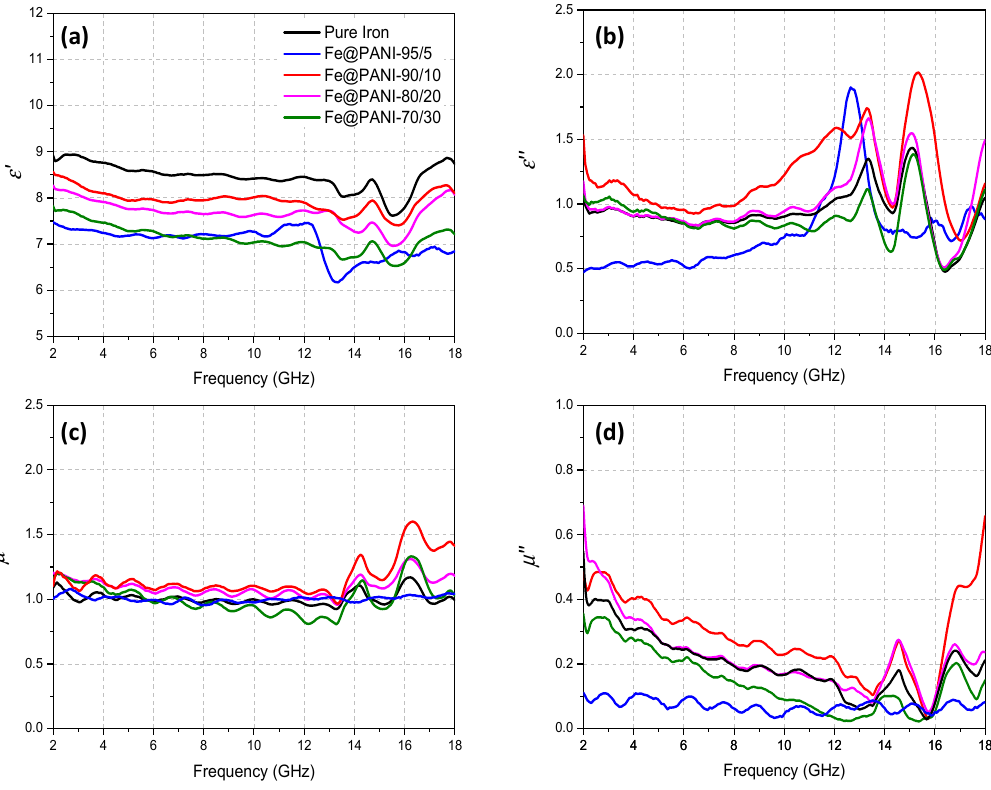
Figure 10. The measured dielectric ( a ) real part ε ′ , ( b ) imaginary part ε ″ , the magnetic ( c ) real part μ ′ , and ( d ) imaginary part μ ″ of Fe@PANI nanowires composites in epoxy resin. Higher electric and magnetic loss may result in better microwave absorption per- formance. In order to compare the dielectric and magnetic dissipation of the Fe@PANI nanowires, Figure 11 shows the dielectric loss factor (tan δ ε = ε (cid:48)(cid:48) / ε (cid:48) ) and the magnetic loss factor (tan δ µ = µ (cid:48)(cid:48) / µ (cid:48) ). Generally, dielectric loss capability exhibited two major peaks at ~13 and 15 GHz, Figure 11a. Whereas the magnetic loss capability, shown in Figure 11b, shows a downward trend within ~2–14 GHz, exhibiting a peak at ~15 GHz, and another one at ~17 GHz. It can be noted that both tan δ ε (Figure 11a, max. ~0.28) and tan δ µ (Figure 11b, max. ~0.5) were less than one. As shown in Figure 11, this suggests that Fe@PANI-90/10 (red curve) may exhibit the best overall performance when considering both tan δ ε and tan δ µ